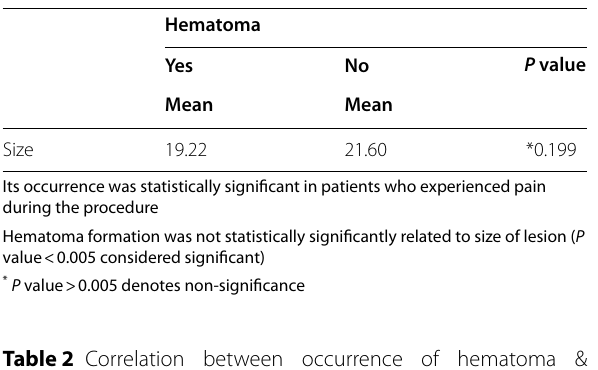
Table 2 Correlation between occurrence of hematoma & ecchymosis and pain experienced during and after procedure